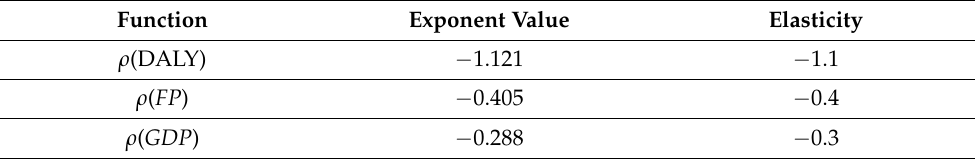
Table 2. The elasticity of energy density indicators characterizing the pillars of sustainable development.